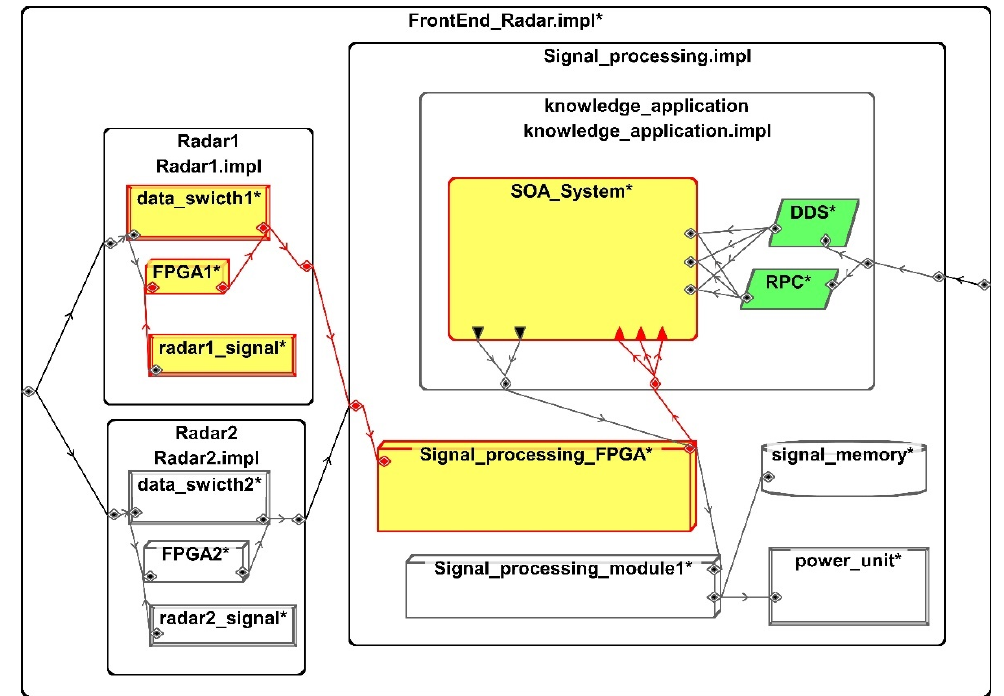
Figure 8. The task path in AADL model.